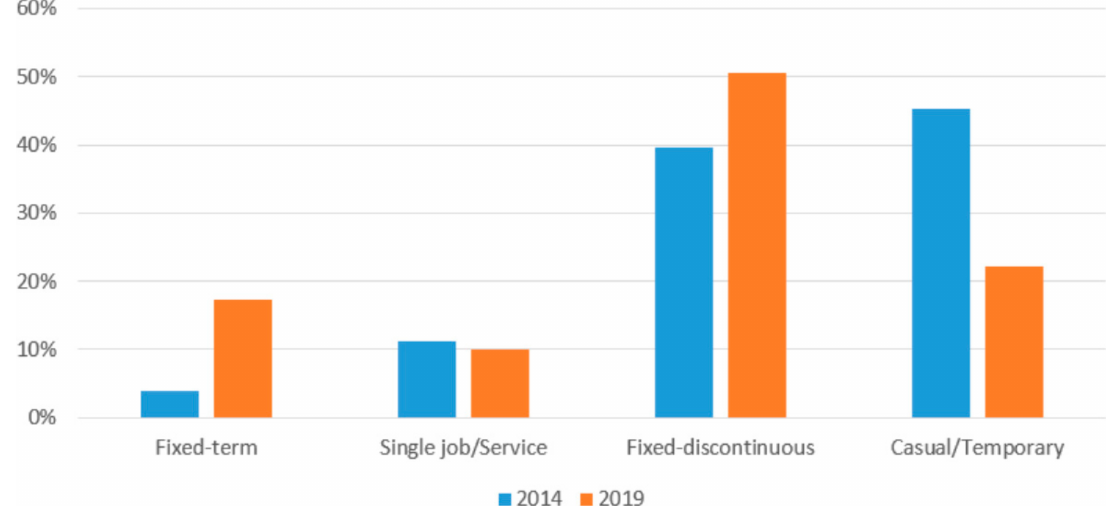
Figure 4. Types of contracts. Source: Compiled by the authors.